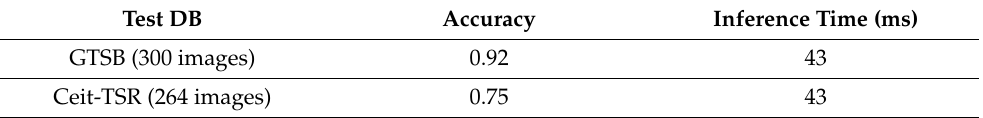
Table 6. Summary results of the classification for the GTSB and Ceit-TSR datasets. The influence of the complex images on the selected classifier is